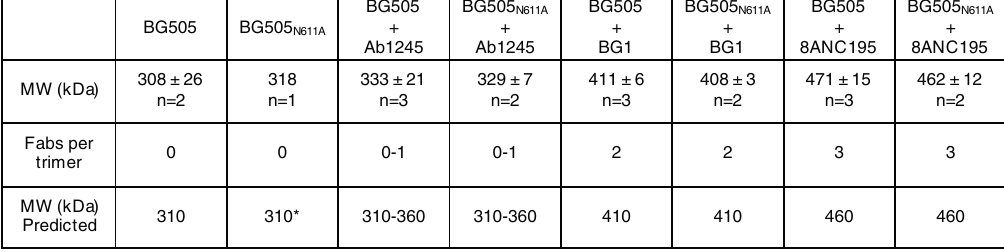
Fig. 1 Characterization of Ab1245 elicited in macaques by sequential immunization. a Sequential immunization protocol for the macaque that produced Ab1245 over the course of 40 weeks. b Sequence alignment of Ab1245 heavy and light chains with their germline precursors. Contacts with BG505 Env are indicated by a colored box around the residue (cyan box of CDRH3 contact residues; dark pink and light pink boxes for heavy chain and light chain contact residues, respectively). Residues within CDRs are indicated; residues between CDRs are within framework regions (FWRs). CDRH3 residues derived from VDJ joining are shown as dashes in the top germline sequence, and changes from the germline precursors are denoted a different residue in the mature Ab1245 sequence. Residues are numbered using the Kabat convention. c SEC-MALS pro fi les for BG505 SOSIP.664 Env trimer alone and complexed with a threefold molar excess of Ab1245 and 8ANC195 Fabs. Left: absorbance at 280 nm (left y -axis) plotted against elution volume from a Superdex 200 10/300 GL gel fi ltration column overlaid with the molar mass determined for each peak (right y -axis). Right: Table showing predicted and calculated molecular masses. d Mass photometry results. Derived molecular masses (MW) are listed for Env trimers (either BG505 or BG505 N611A ) incubated without an added Fab or with the indicated Fab (Ab1245, BG1, or 8ANC195) as mean and standard deviation for the indicated number of independent measurements. The Fabs/trimer row shows the expected number of Fabs for each Fab/Env trimer complex. The predicted mass row shows the mass calculated assuming 310 kDa for BG505 trimer (derived by SEC-MALS, ( c )) plus 50 kDa per bound